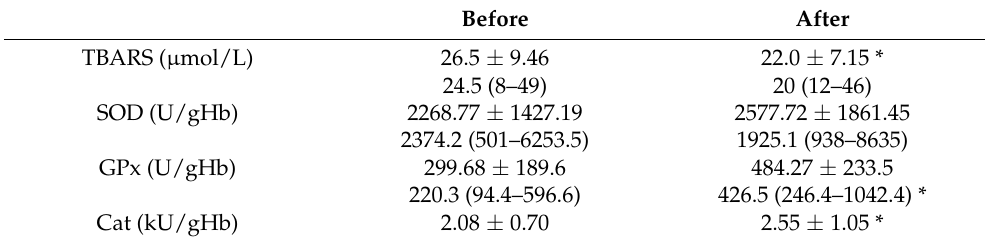
Cat (kU/gHb) 2.08 ± 0.70 2.55 ± 1.05